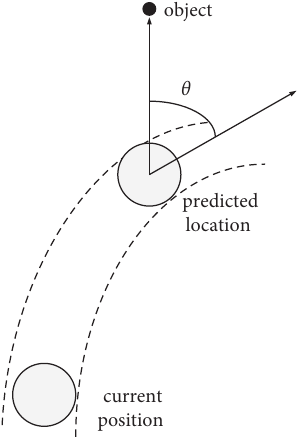
Figure 8: h () evaluation.